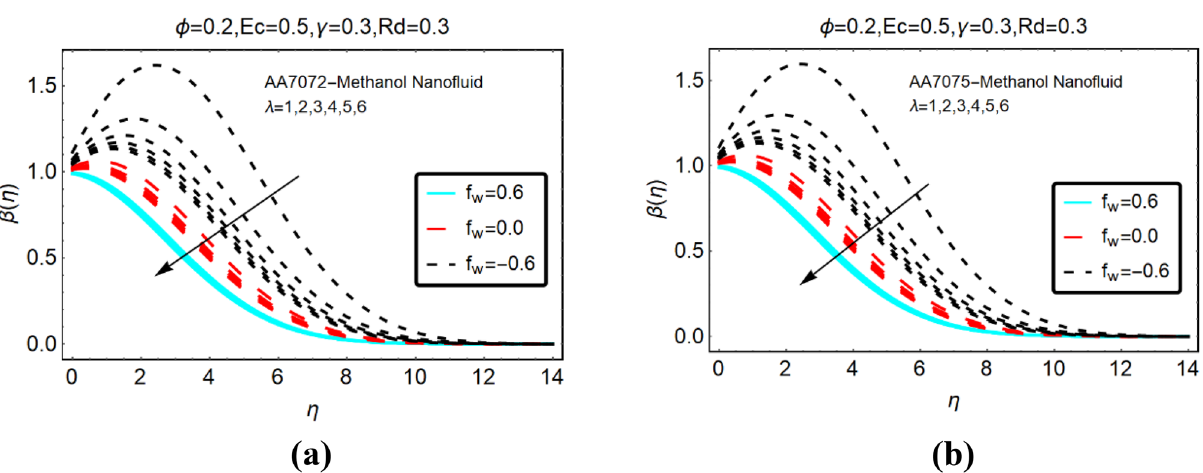
Figure 10. The effects of velocity slip on ( a ) AA7072-Methanol ( b ) AA7075-Methanol.